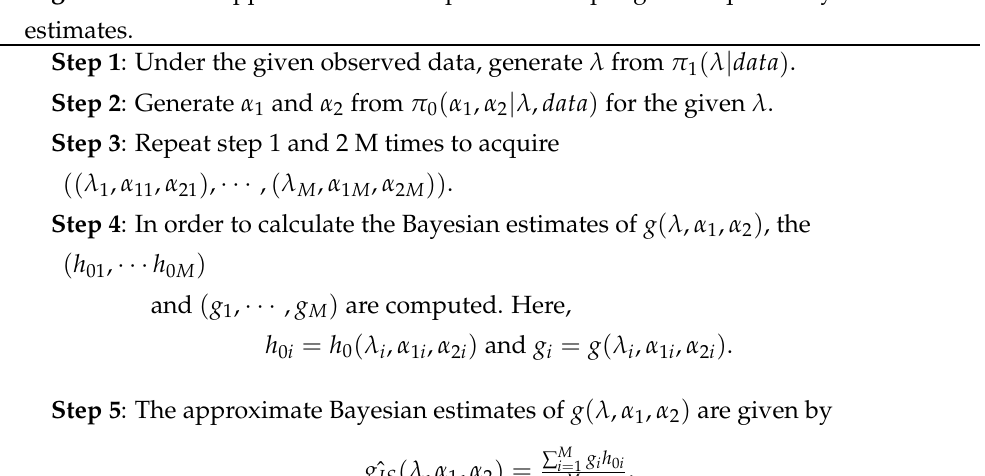
Algorithm 2: The application of the importance sampling technique in Bayesian